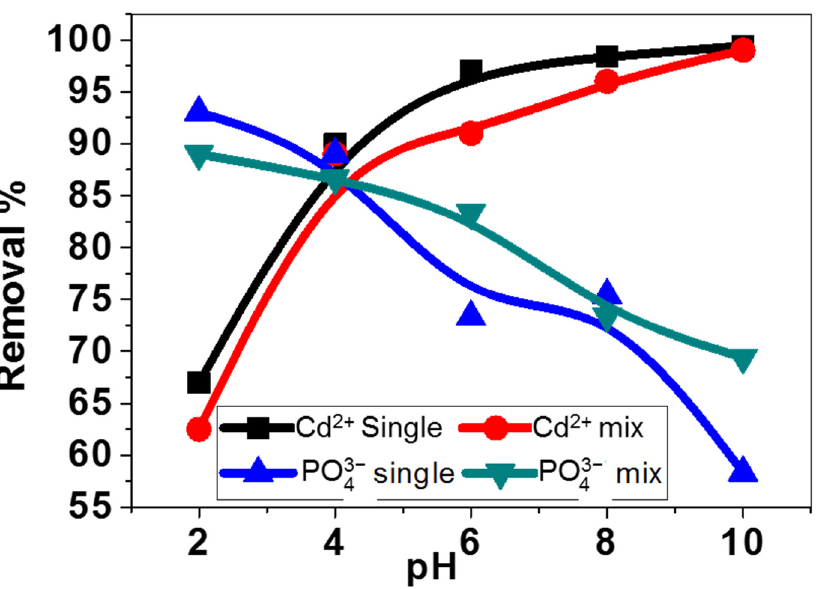
Figure 8. Effect of solution pH on the removal% in single and binary solutions.